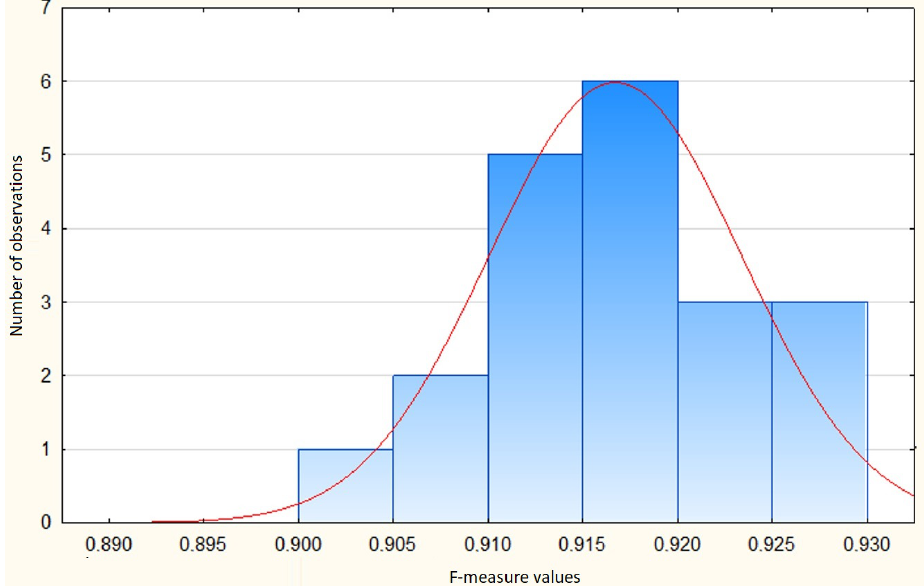
Figure 13. F-measure distribution histogram.